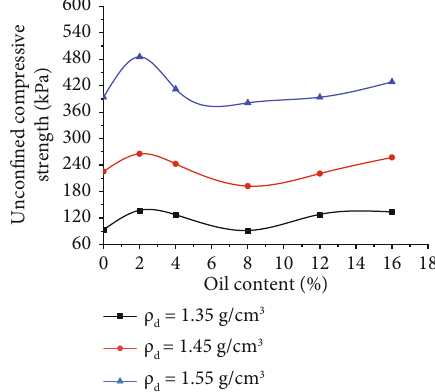
Figure 10: Uncon fi ned compressive strength of diesel- contaminated loess under the second mode of oil